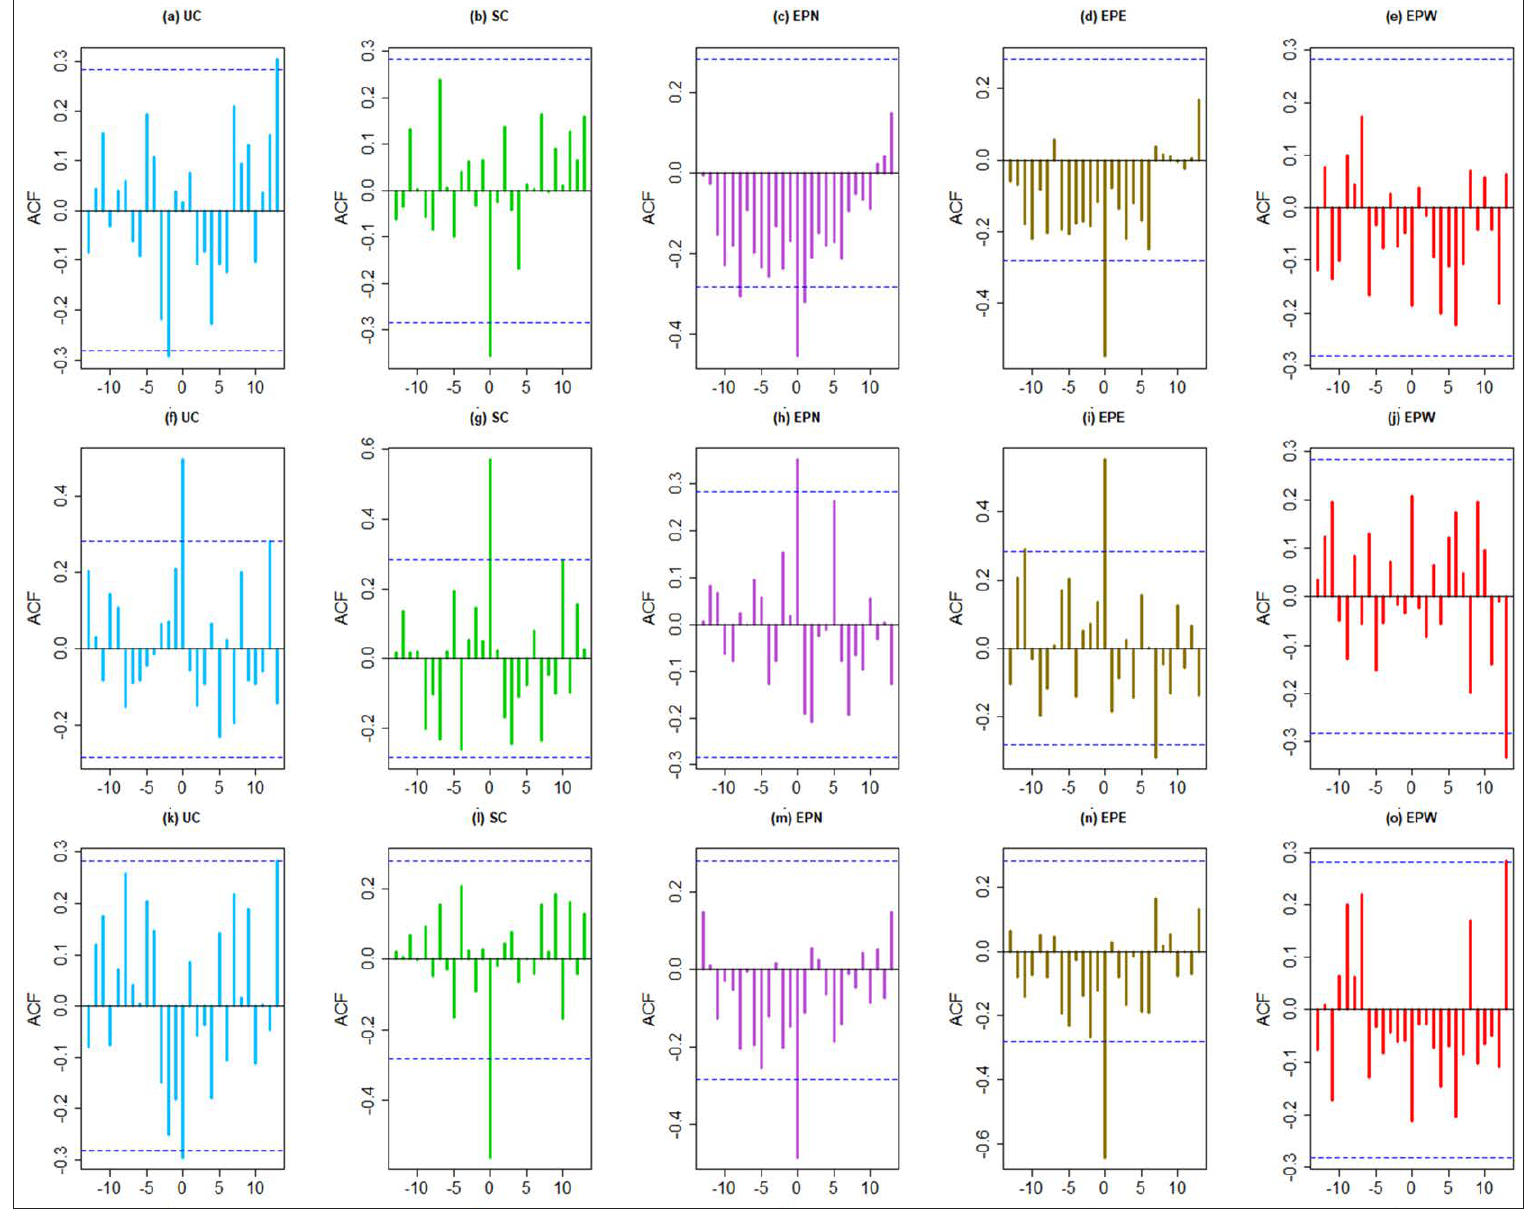
Figure S3. Cross-correlation between annual streamflow depth (in mm) and (a)-(e): annual mean temperature, (f)-(j): annual total precipitation, in mm, (k)-(o): annual total PET, in